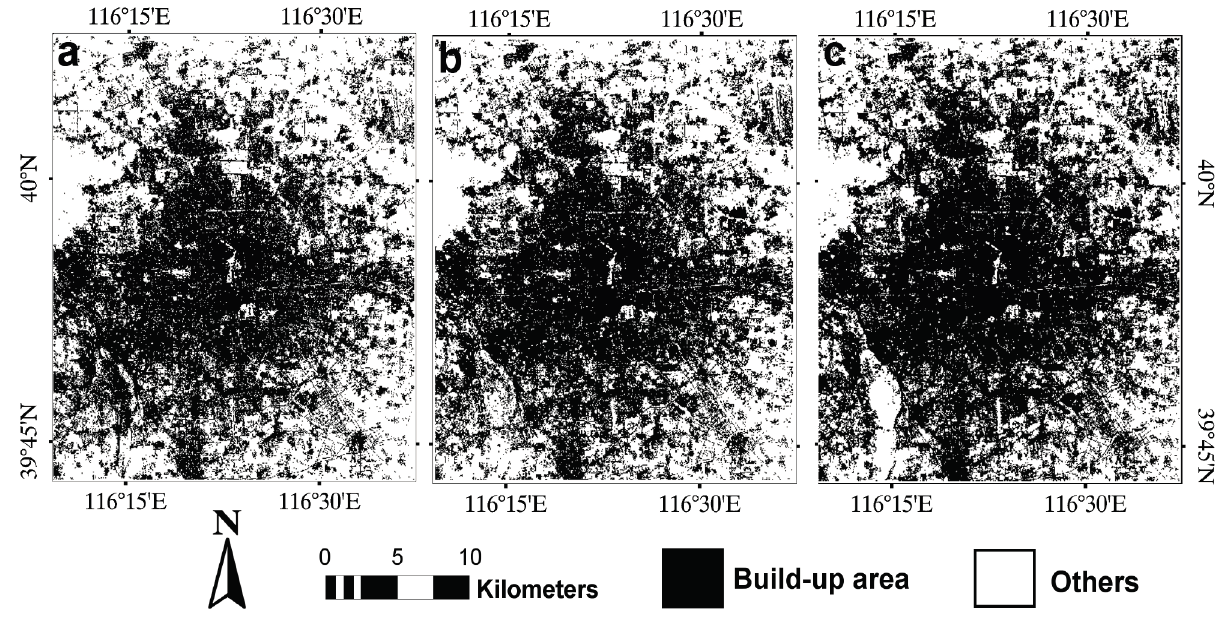
Figure 5. Classification results of the 2005 Beijing image using spectral information alone ( a ); using spectral information and one-band texture ( b ); and using spectral information and multivariate texture with spectral angle distance ( c